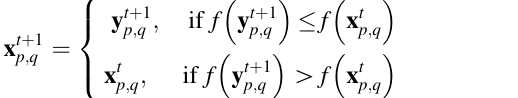
Fig. 1 Flowchart of well placement optimization based on Theil index and DE